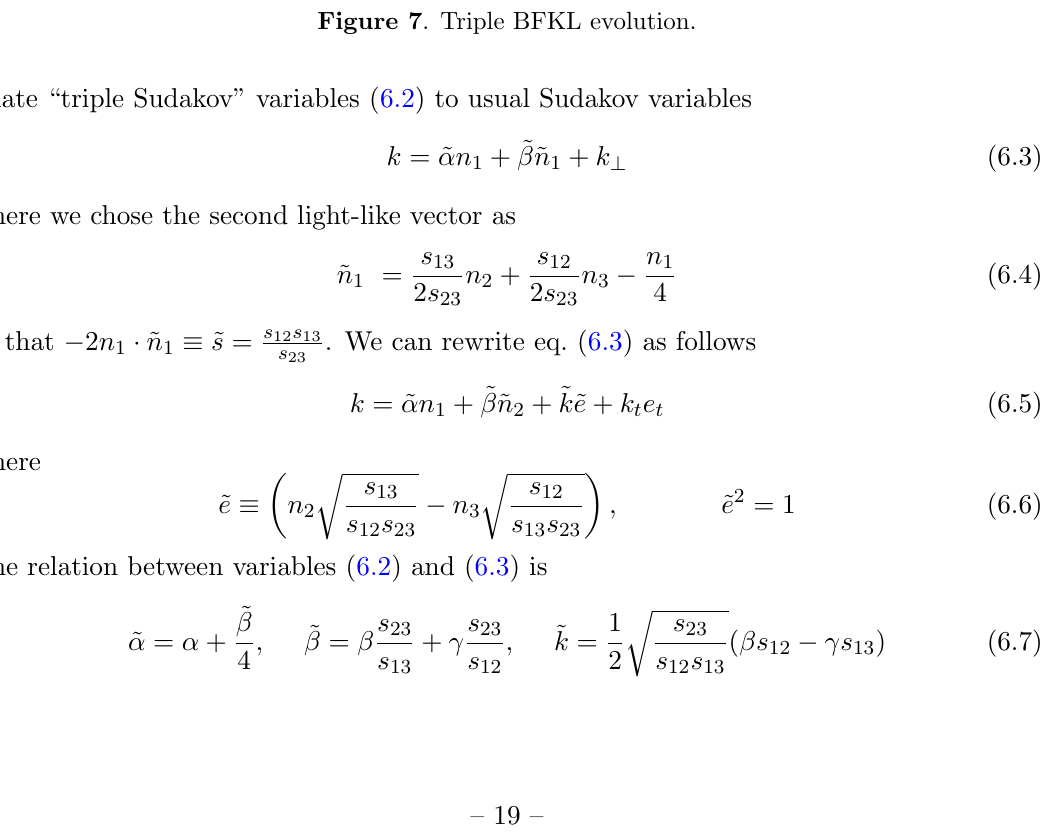
Figure 7 . Triple BFKL